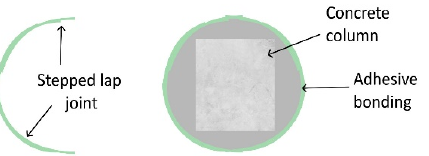
Figure 11. Modifying square concrete columns by using GFRP shell stepped lap joint.